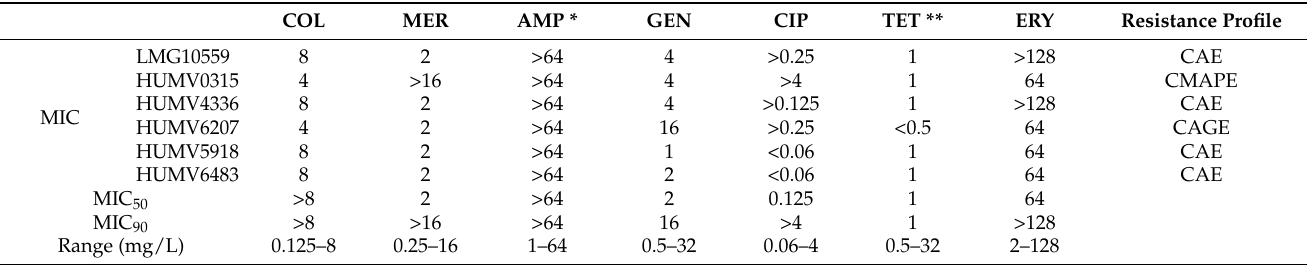
Table 1. List of MICs (mg/L) of each antimicrobial (top) for each A. pittii strain (left), and their resistance profile (right column). COL (C) colistin; MER (M) meropenem; AMP (A) ampicillin; GEN (G) gentamicin; CIP (P) ciprofloxacin; TET (T) tetracycline; and ERY (E) erythromycin. MIC, minimum inhibitory concentration; MIC 50 , MIC that inhibits 50% of the isolates; MIC 90 , MIC that inhibits 90% of the isolates. * No specific value for Acinetobacter spp.; general with no species-specific breakpoints used. ** CLSI breakpoints used.